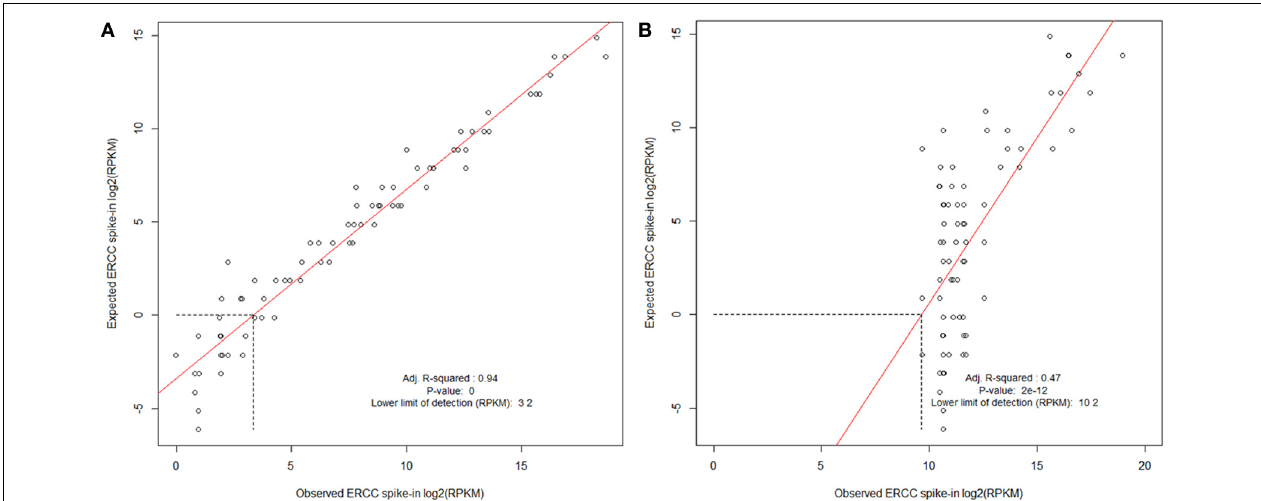
FIGURE 7 | Evaluating ERCC spike-in control results. Examples of cDNA libraries prepared from Arabidopsis thaliana RNA and Mouse infected with Burkholderia pseudomallei RNA containing ERCC Spike-In. Spike-In mix was added to total RNA before preparation of the sequencing library. (A) A. thaliana poly-A RNA was isolated, and a sequencing library prepared using ScriptSeq v2 (Epicentre). (B) Trial B. pseudomallei sequencing library was prepared from RNA extracted from liver of a B. pseudomallei infected mouse; prokaryotic RNA was enriched using Microbe enrich kit (Invitrogen) and bacterial ribosomal RNA was reduced using MicrobeExpress (Invitrogen)